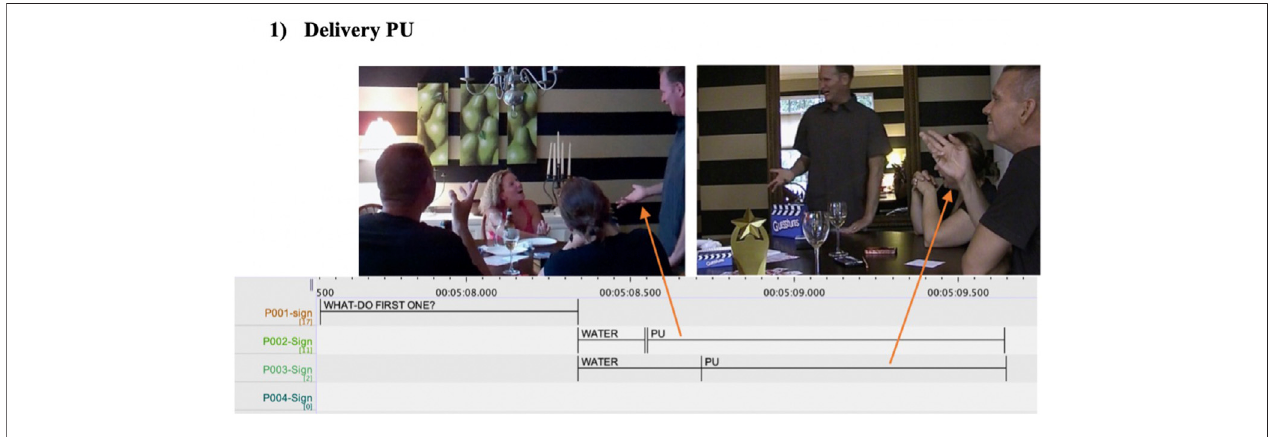
FIGURE 7 | Delivery PU by ASL signers (P002, P003).